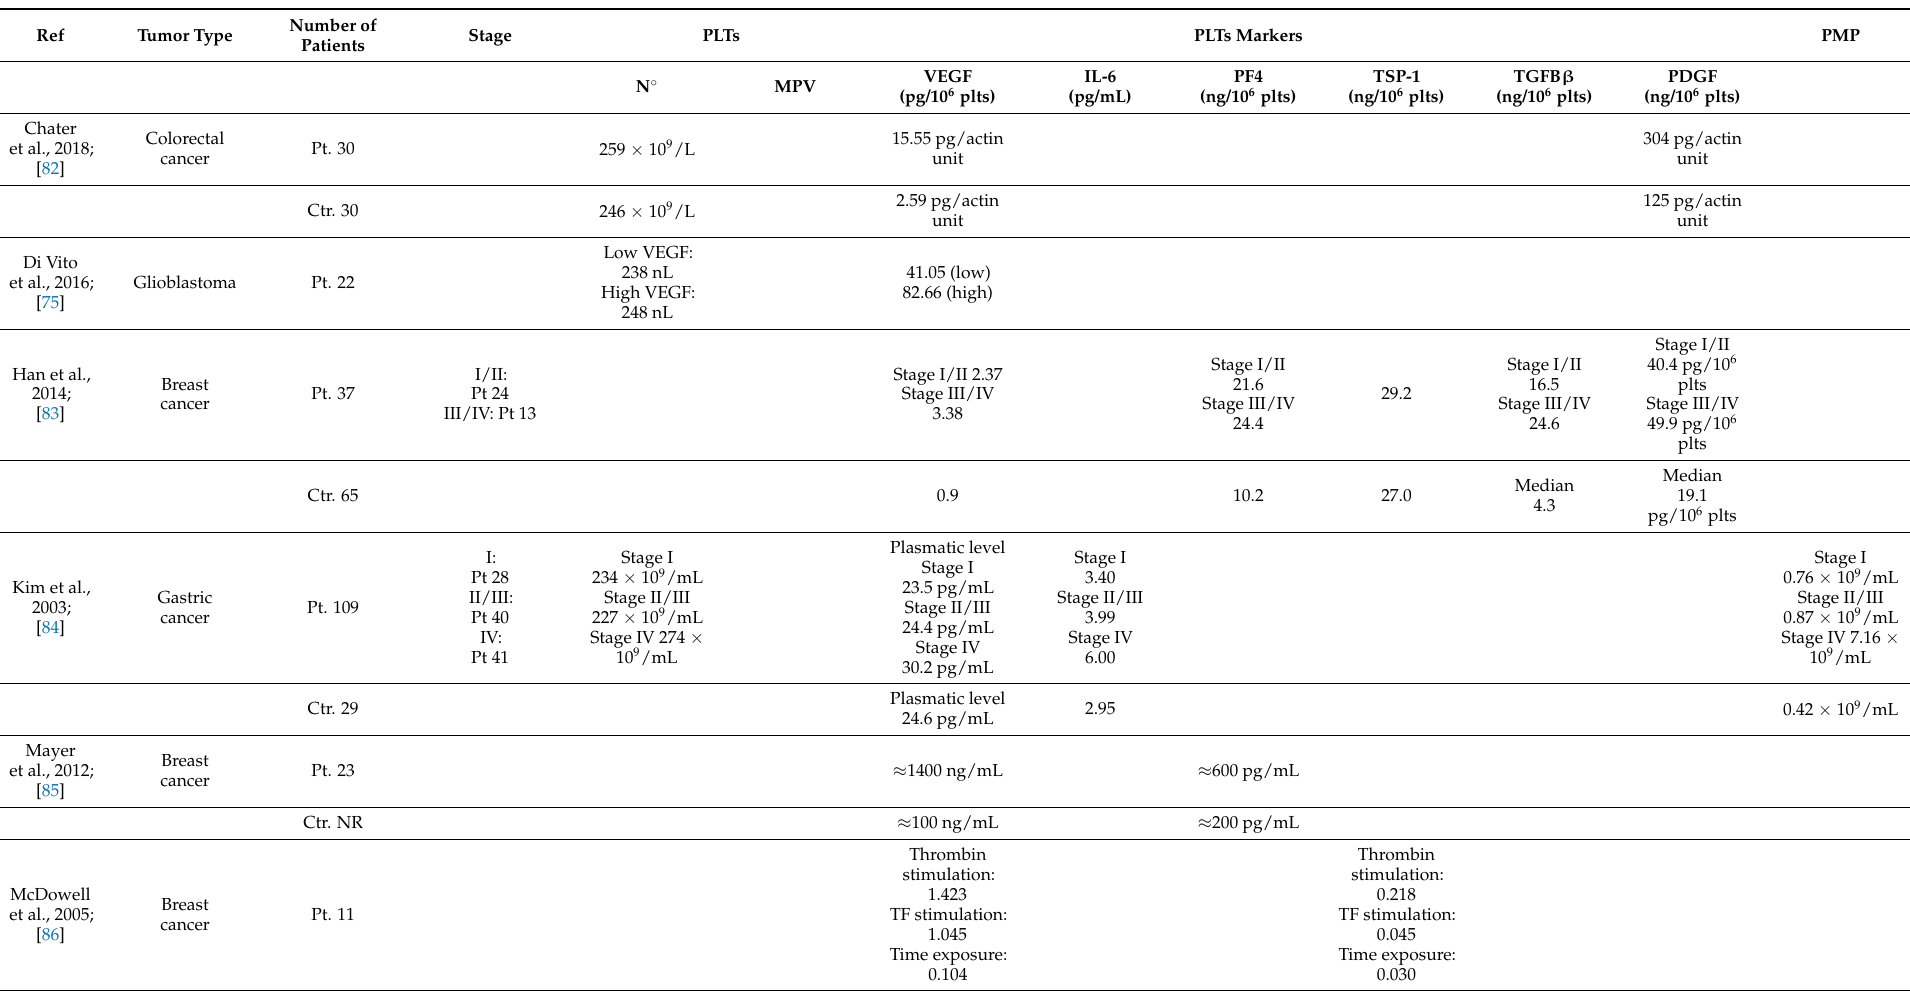
Table 3. Clinical evidence of platelet involvement on tumor